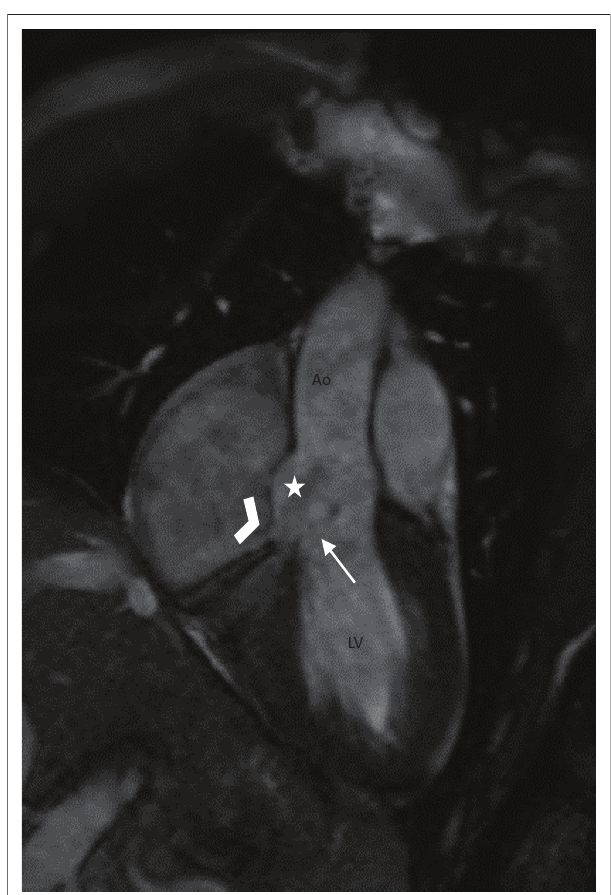
FIGURE 1: Coronal SSFP image of the aortic valve demonstrates an aneurysm (arrowhead) of the sinus of Valsalva ( * ). The coronal image demonstrates the aneurysm above the level of the leaflet (white arrow). Cine image available at https://www.youtube.com/watch?v=mHb_6cMlHMQ&feature= youtu.be